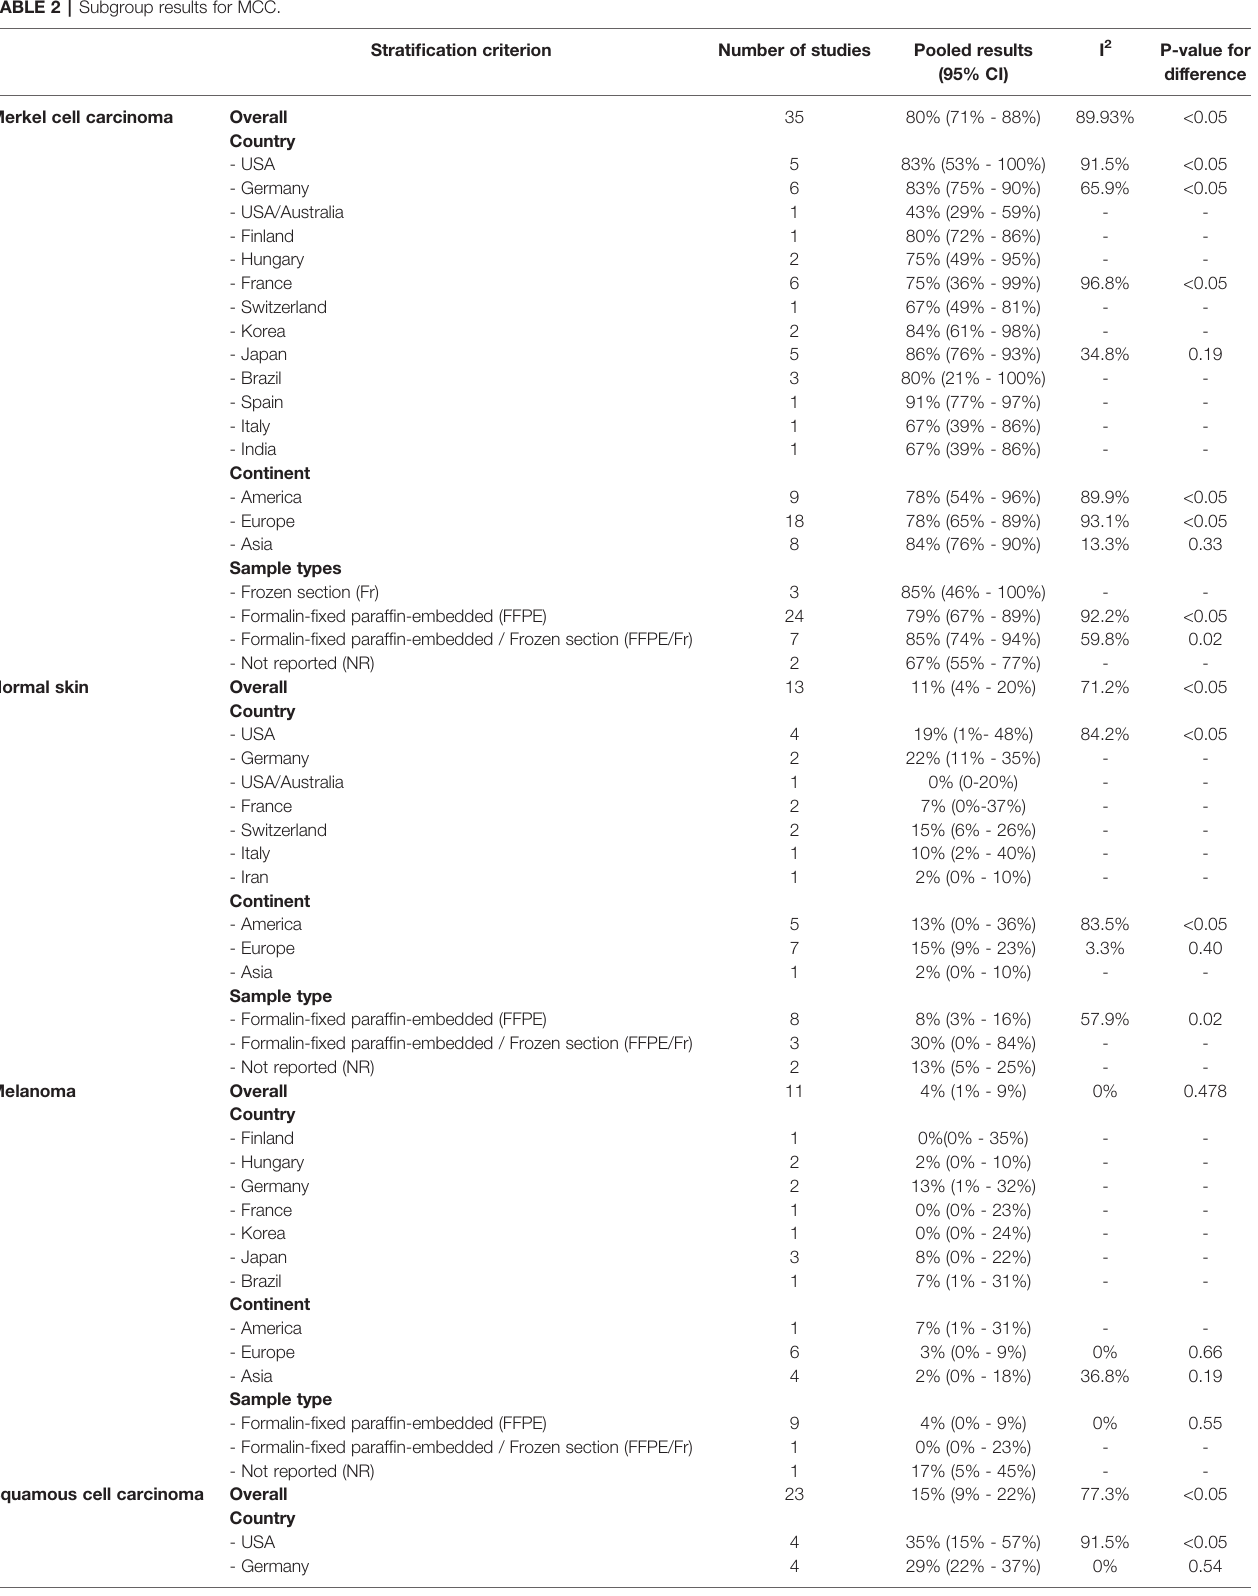
TABLE 2 | Subgroup results for